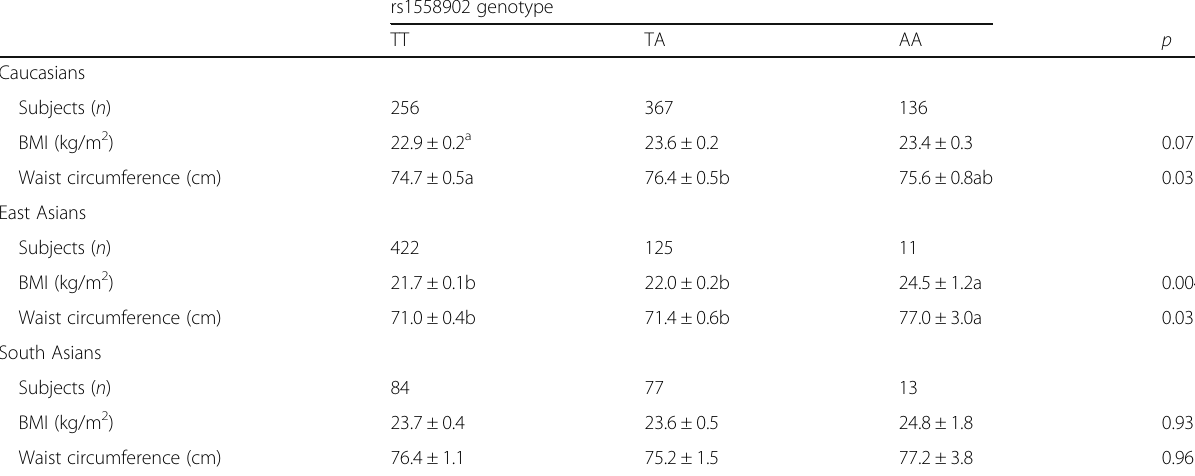
Table 2 FTO genotype and measures of body weight stratified by ethnicity rs1558902 genotype